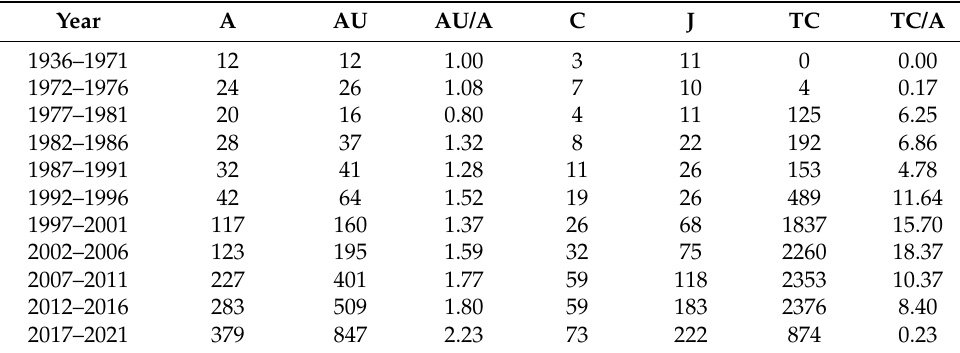
Table 2. Major characteristics of the scientific production on pension research.